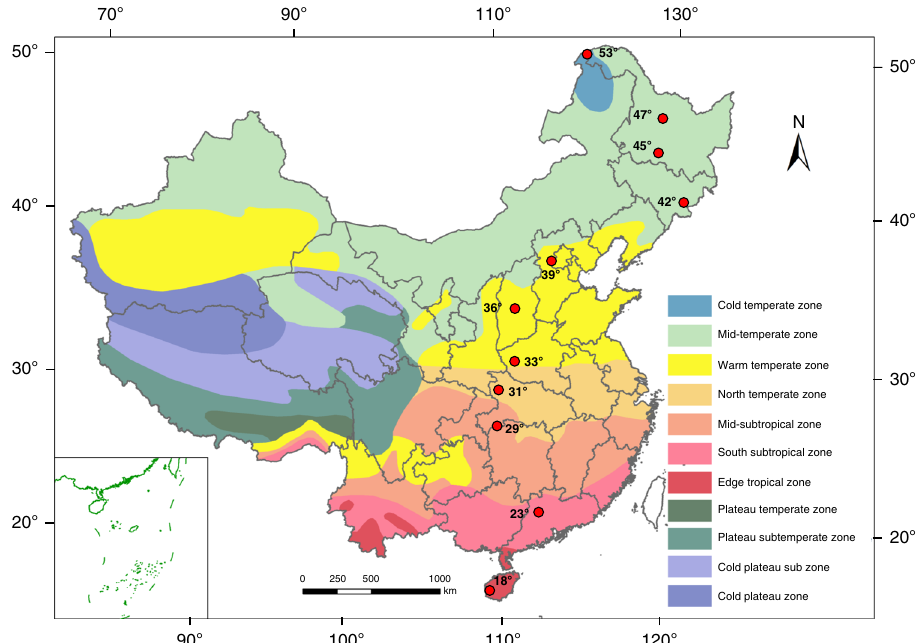
Fig. 1 The distribution of 11 sampling regions along the latitudinal gradient transect. Red circles indicate the sampling regions. In each region, 60 plots (each of 20 × 20 m) were established. A detail spatial distribution map of the sampling plots is shown in Supplementary Fig. 1. The source data are provided as a Source Data fi